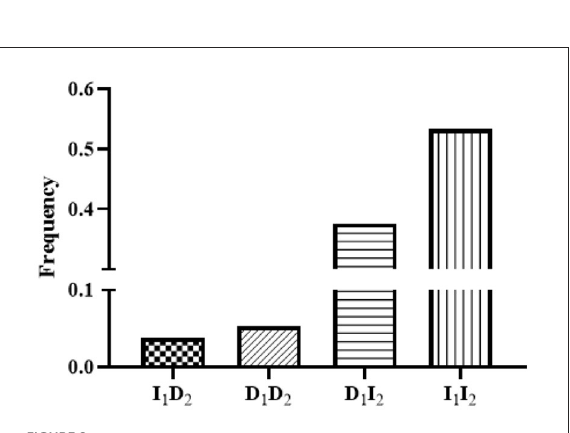
FIGURE2 Haplotype frequencies of the two InDels within the goat SNX29 gene. The 1 means P1-Del-17bp, 2 means P2-Del-20bp. CNV3 = 239, CNV4 = 133, CNV5 = 197) was higher than Loss and Median, and the Gain frequencies in four sites (CNV1 = 0.834, CNV3 = 0.872, CNV4 = 0.516, CNV5 = 0.563) were significantly higher (Table 2).